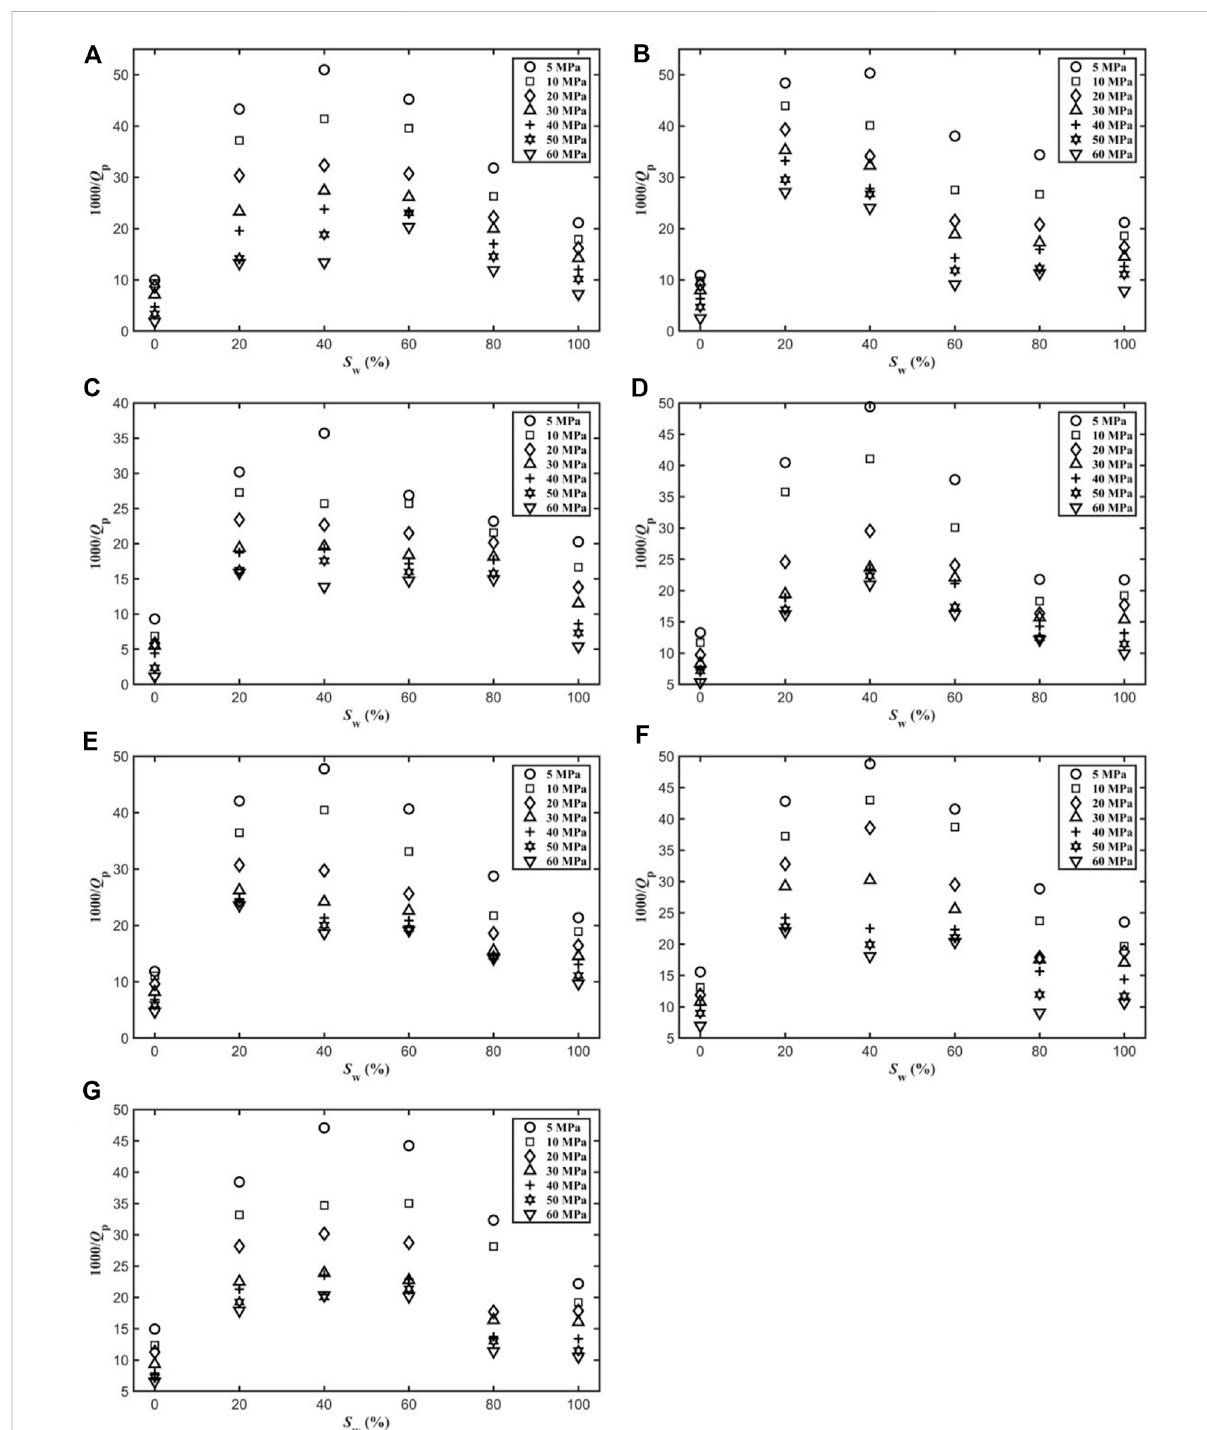
FIGURE 4 P-wave attenuation as a function of water saturation for samples of 1 – 3 (A) , 1 – 12 (B) , 1 – 19 (C) , 1 – 23 (D) , 2 – 7 (E) , 2 – 8 (F) and 2 – 9 (G) , and different con fi ning